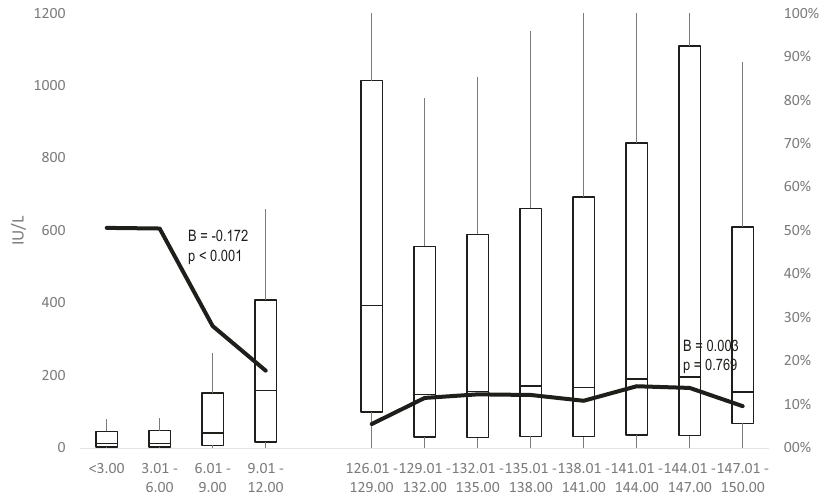
Fig. 1 Long-term anti-HBs titre (boxplot, left y axis) and proportion of individuals below 10 IU/l (black line, right y axis) by age (months) at the fi rst dose vaccine administration.